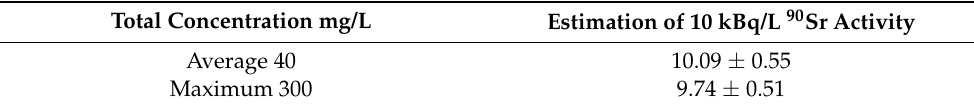
Table 6. The estimate of 90 Sr activity from a realistic groundwater borehole with different concentra- tions of suspended non-radionuclide particles.